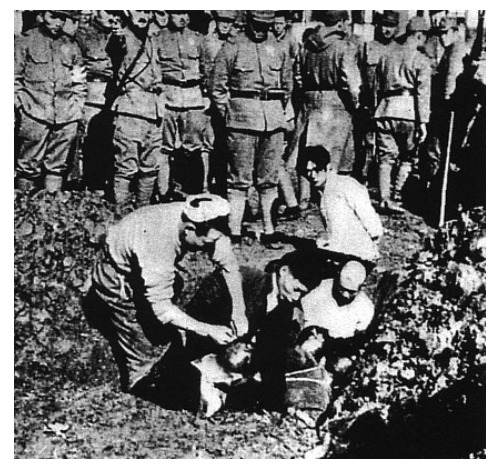
Figure 9. Burying Chinese prisoners alive. Source: Keystone/Getty Images.